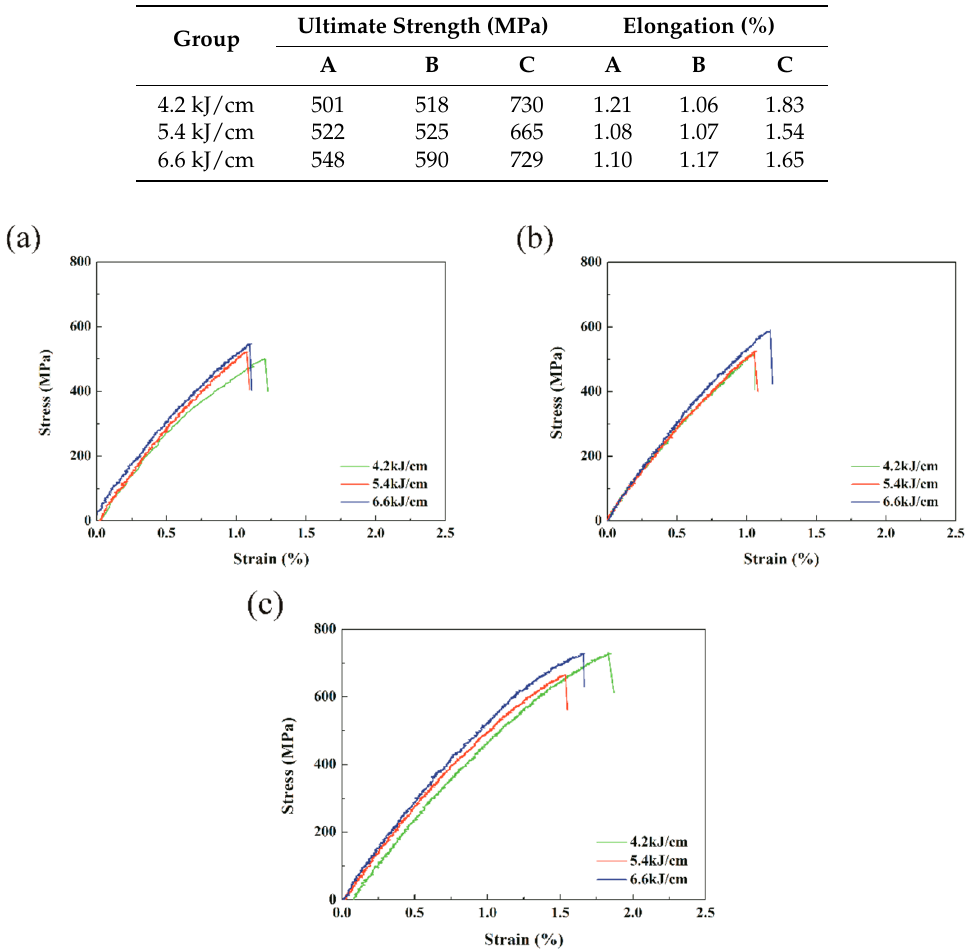
Figure 6. Stress-strain curve of weld joints. ( a ) Samples A; ( b ) Samples B; and ( c ) Samples C.